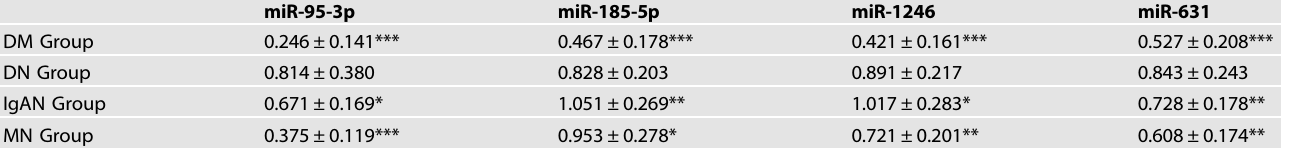
Table 1. Comparison of urinary sediment microRNA expression pro fi les among different groups in the con fi rmation cohort.